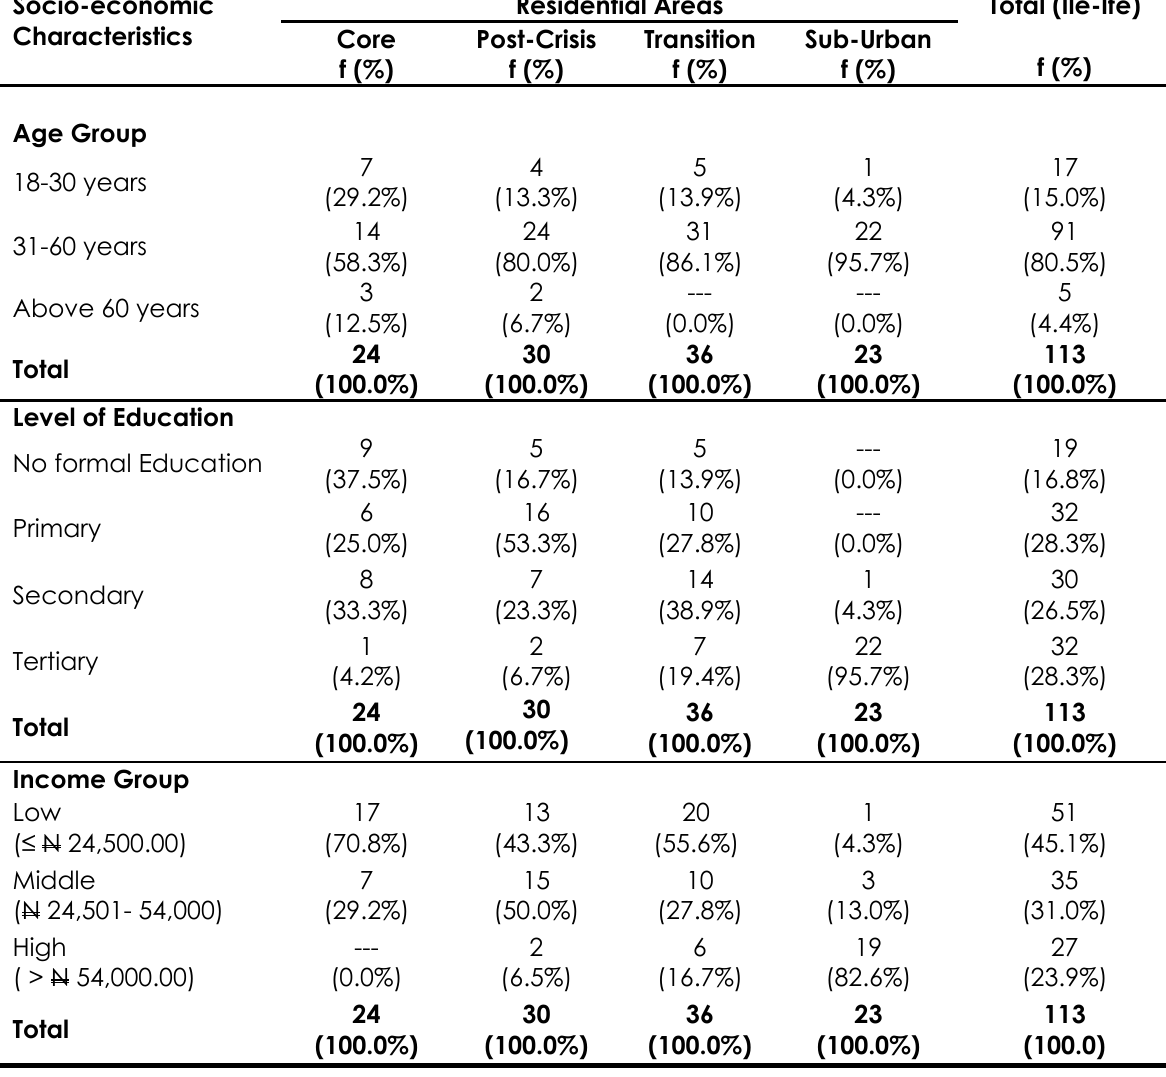
Table 2. Socioeconomic characteristics of the respondents (household